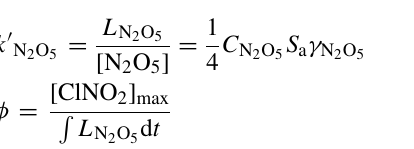
, and trace gases and 3